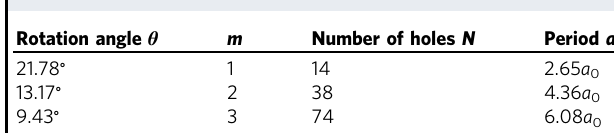
Table 1 Parameters of the superlattices of three holey twistsonic media under